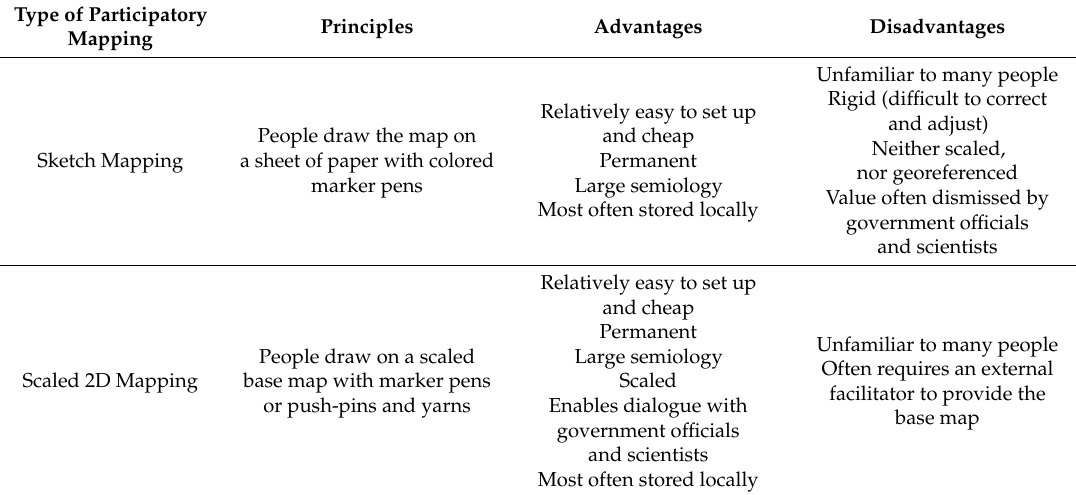
Table 2. Main characteristics of the di ff erent forms of participatory mapping used in this study. Adapted from